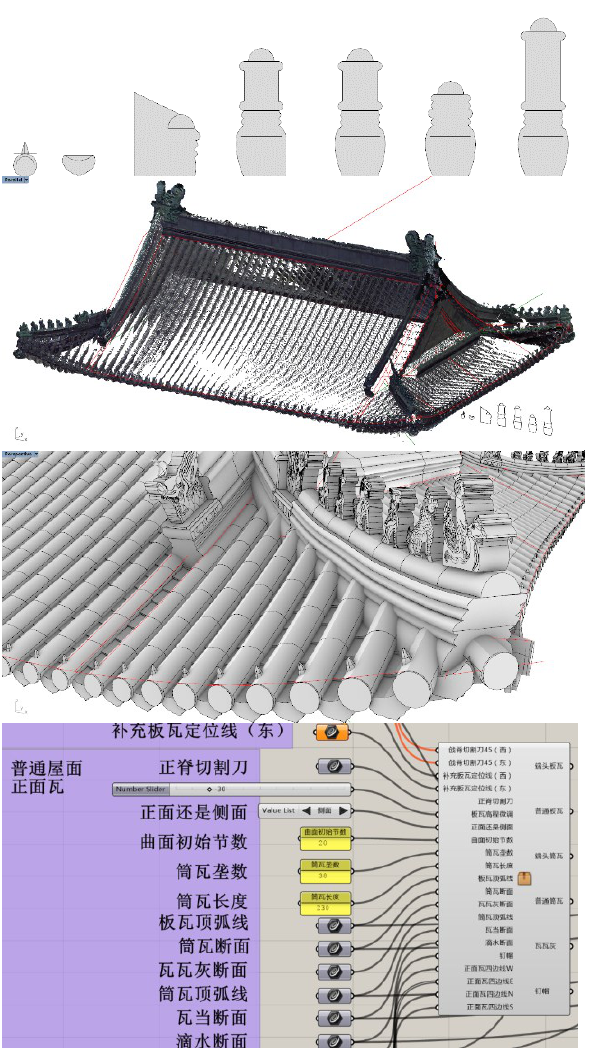
Figure 9. Section profile, skeleton curve, model and input